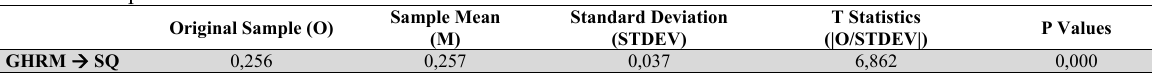
Sample Mean Standard Deviation T Statistics P Values (M) (STDEV) (|O/STDEV|)